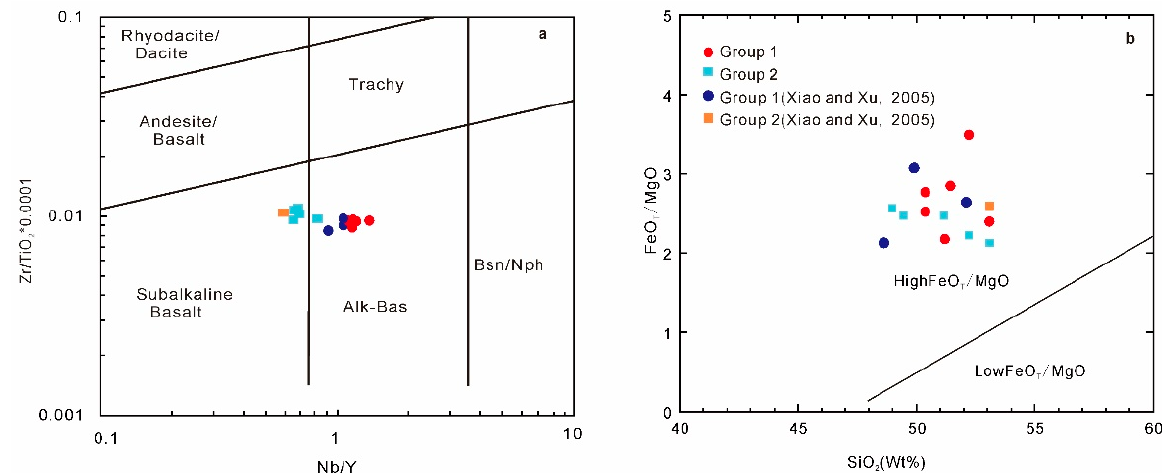
Figure 6. ( a ) Nb/Y vs. Zr/TiO 2 diagram [56]; ( b ) SiO 2 vs. FeO T /MgO diagram [57].